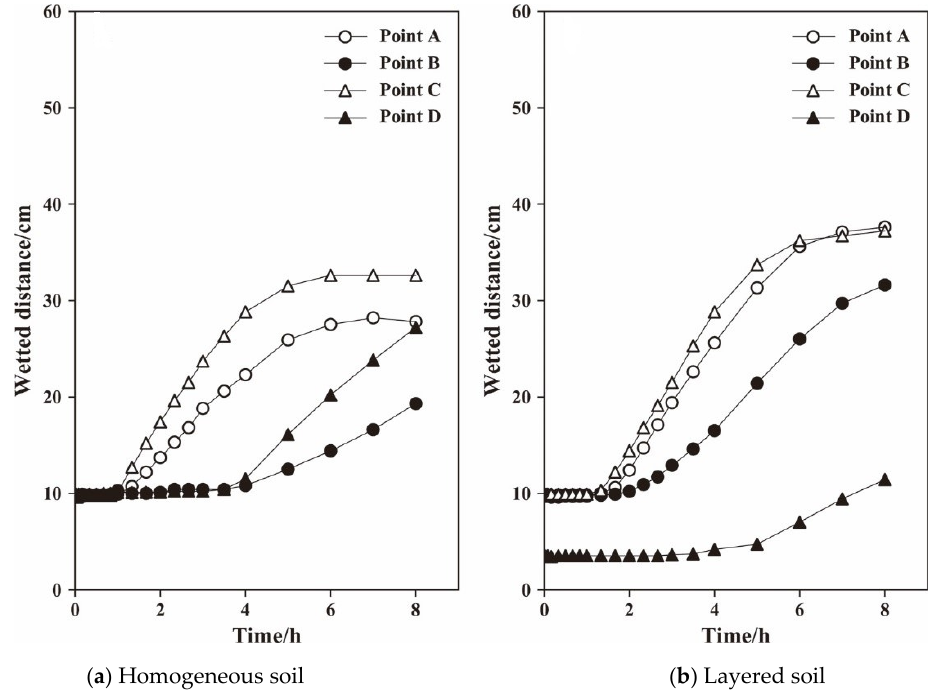
Figure 10. Migration of soil moisture content over time monitored using soil sensors.